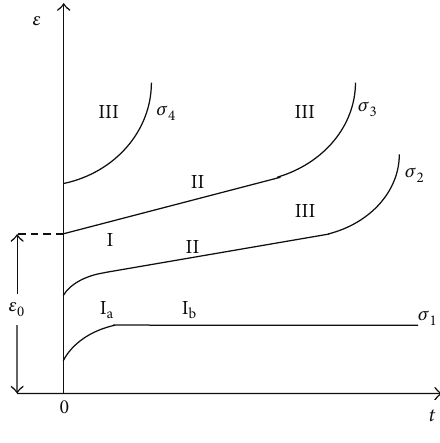
Figure 1: Various types of creep